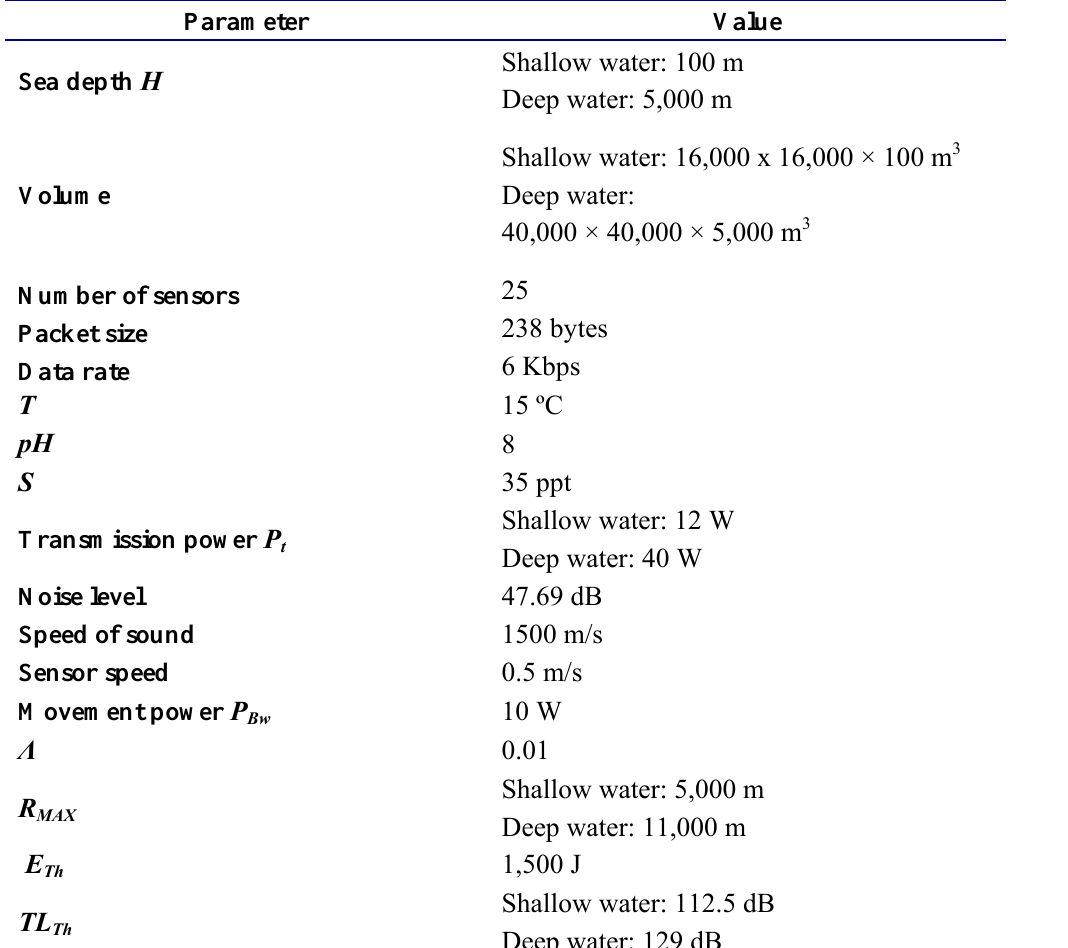
Table 1. Parameter